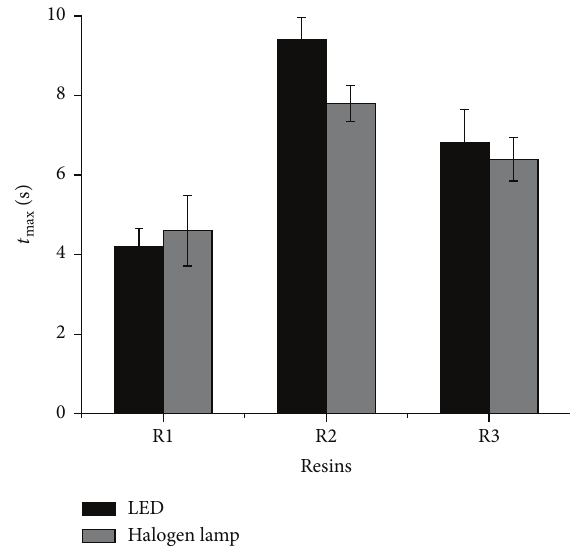
Figure 2: Graph of the mean and standard deviation for the DC (%) after 300 seconds for thethree resins(R1, R2, and R3) photoactivated by two light sources (LED and halogen lamp).